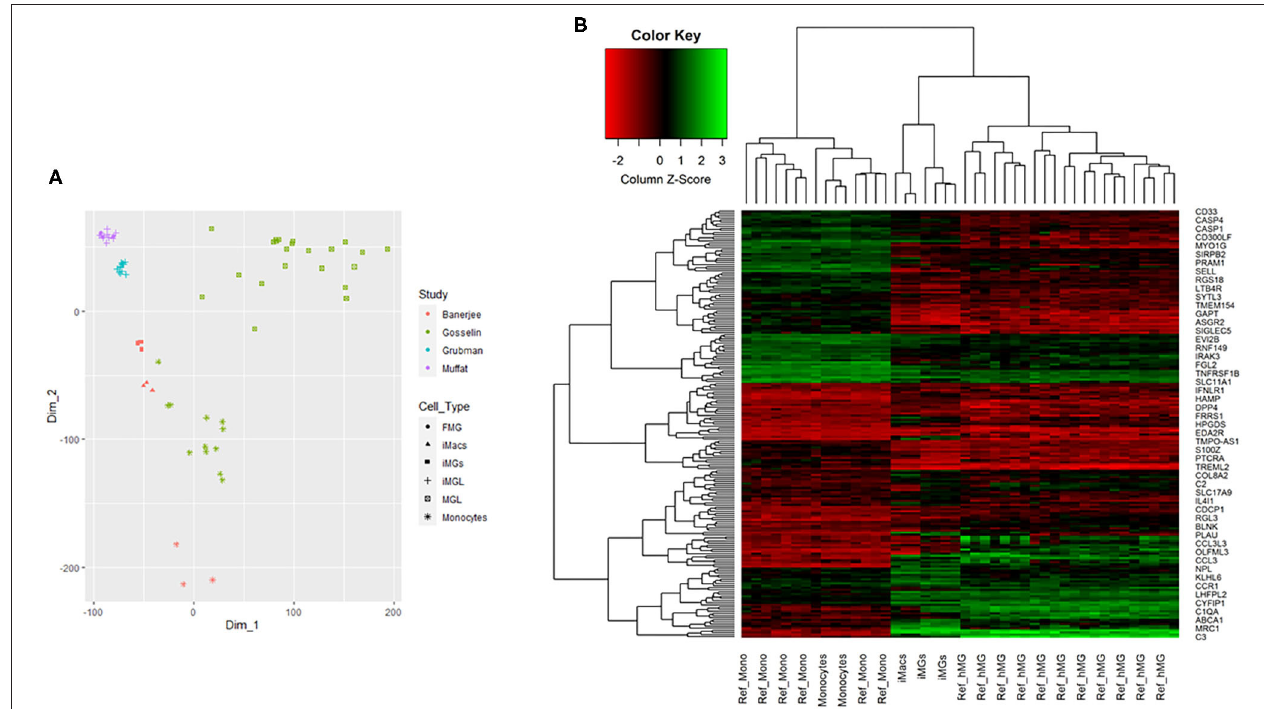
FIGURE 5 | Multidimensional scaling analysis (MDS) and 2D hierarchical clustering from RNA-seq profile of iMG cells. (A) MDS analysis for multiple RNA-seq datasets, including iMG cells, iMacs, and monocytes from our study, hiPSC-induced microglia (iMGL) and fetal microglia (FML) from Muffat et al.’s study, iMGL from Grubman et al.’s study, and human brain microglia (MGL) and monocytes from Gosselin et al.’s study. (B) 2D hierarchical clustering with 201 top differentially expressed genes from our study and Gosselin et al.’s study, where Ref_hMG and Ref_Mono were human brain-resident microglia and monocytes from Gosselin et al.’s study ( Gosselin et al., 2017). iMG cells were induced microglia-like cells from monocytes and iMacs were induced macrophages from monocytes in our